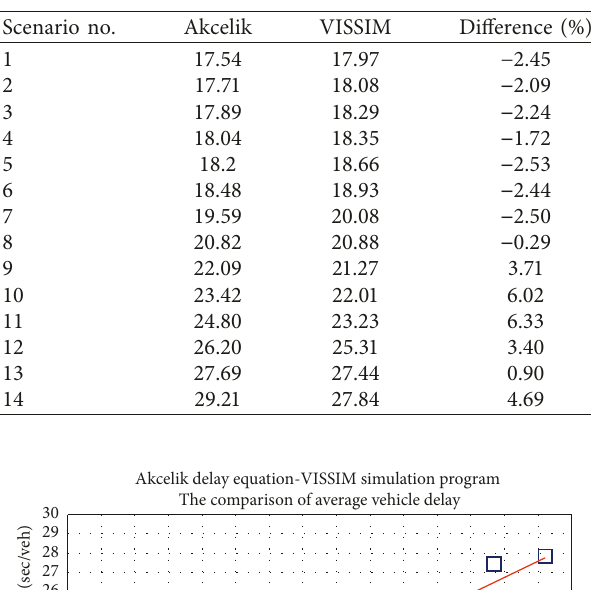
Table 4: Scenario-based comparison of average vehicle delay values.